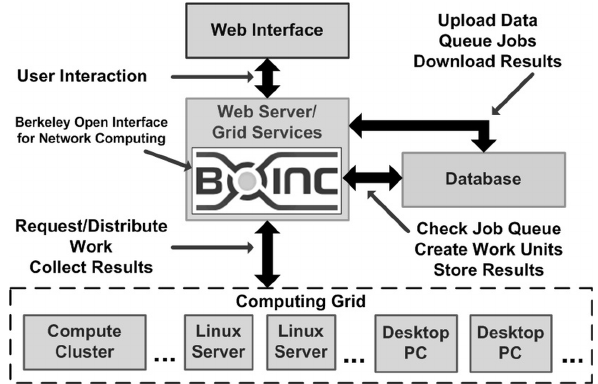
Figure 1. Architecture of the BOINC project. The platform is centralized and includes server and user-side parts. User-side part consists of a client and a graphical program – BOINC Manager. The manager brings the GUI for controlling of one or many BOINC clients. Proper details of BOINC project can be found in [3], improvements in [4]. The most recent changes and documentation can be obtained from the Github repository and the o ffi cial